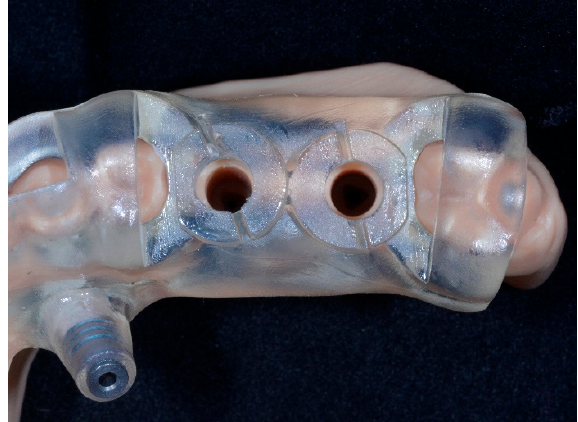
Figure 2. Surgical template without metallic sleeves: Closed sleeves.